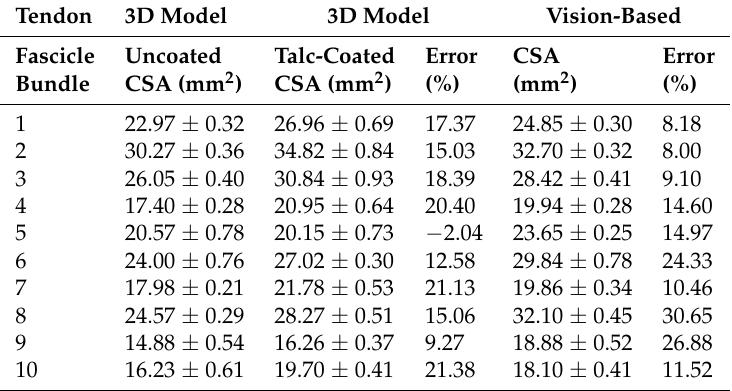
Figure 3. Development of the 3D model of the sample from four 3D profiles scanned every 90 °. The profiles were assembled into a single 3D surface model considering concavities, followed by the generation of the tetragonal mesh for further computational strength analysis. Geometry of the sample with a variable cross-section is shown. Table 3. The calculated cross-sectional areas (CSA) of tendon fascicle bundles estimated using the 3D scanning system for uncoated and talc-coated samples compared to vision-based measurements. Number of repeated measurements per sample n = 6. Data concerning CSA are presented as means with standard